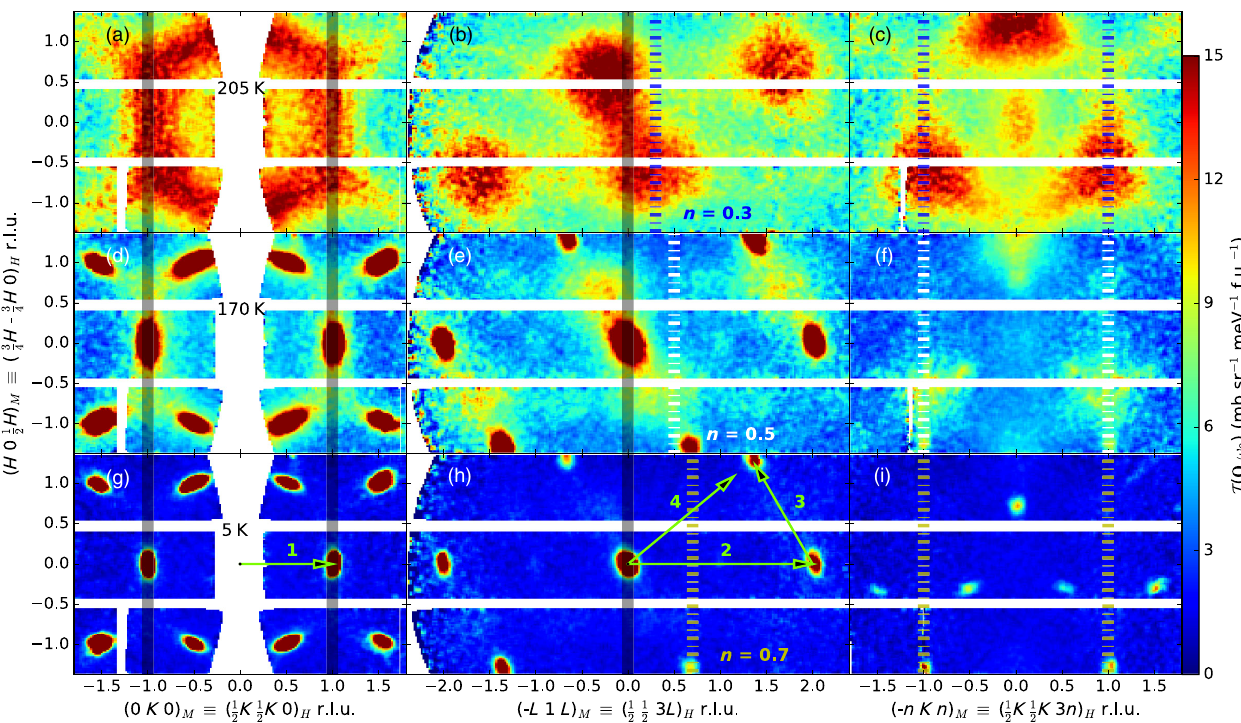
¼ 50 meV) for ð V Þ 5 < ℏ ω 10 meV. FIG. 2. Constant energy slices of INS data ( E 0 . 96 Cr 0 . 04 0 < 2 O 3 ; energy transfer averaged from i Each horizontal row shows I ð Q ; ω 0 Þ for the three temperatures marked along the phase diagram in Fig. 1. The left-hand column, (a), (d), and (g), shows I ð Q ; ω 0 Þ in the pseudohexagonal basal plane at the origin ( L ¼ 0 ). The center column, (b), (e), and (h), covers a plane perpendicular to that of the left-hand column overlapping at the light gray solid lines. The right-hand column, (c), (f), and (i), shows ¼ 3 n , where n ¼ 0 . 3 , 0.5, and 0.7 for frames (c), (f), and (i), respectively, as indicated in the center pseudohexagonal planes for L H column by the colored dashed lines. Green arrows indicate the four high-symmetry directions used in Fig.